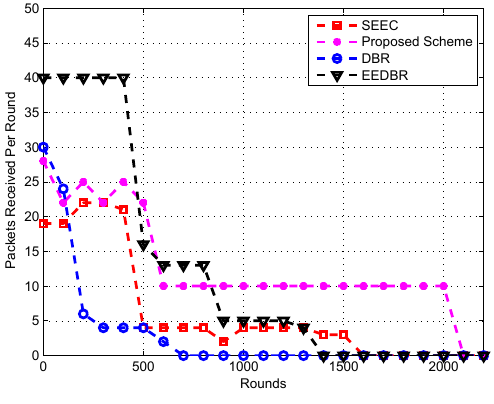
Figure 5. Packets received per